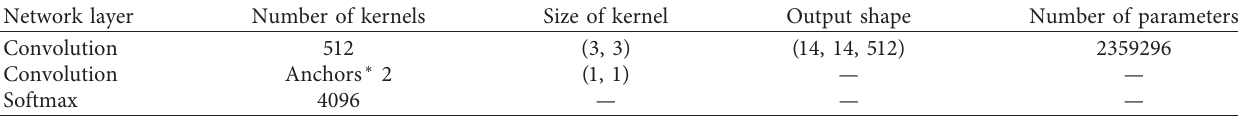
Table 1: The composition and parameter setup of neural network.